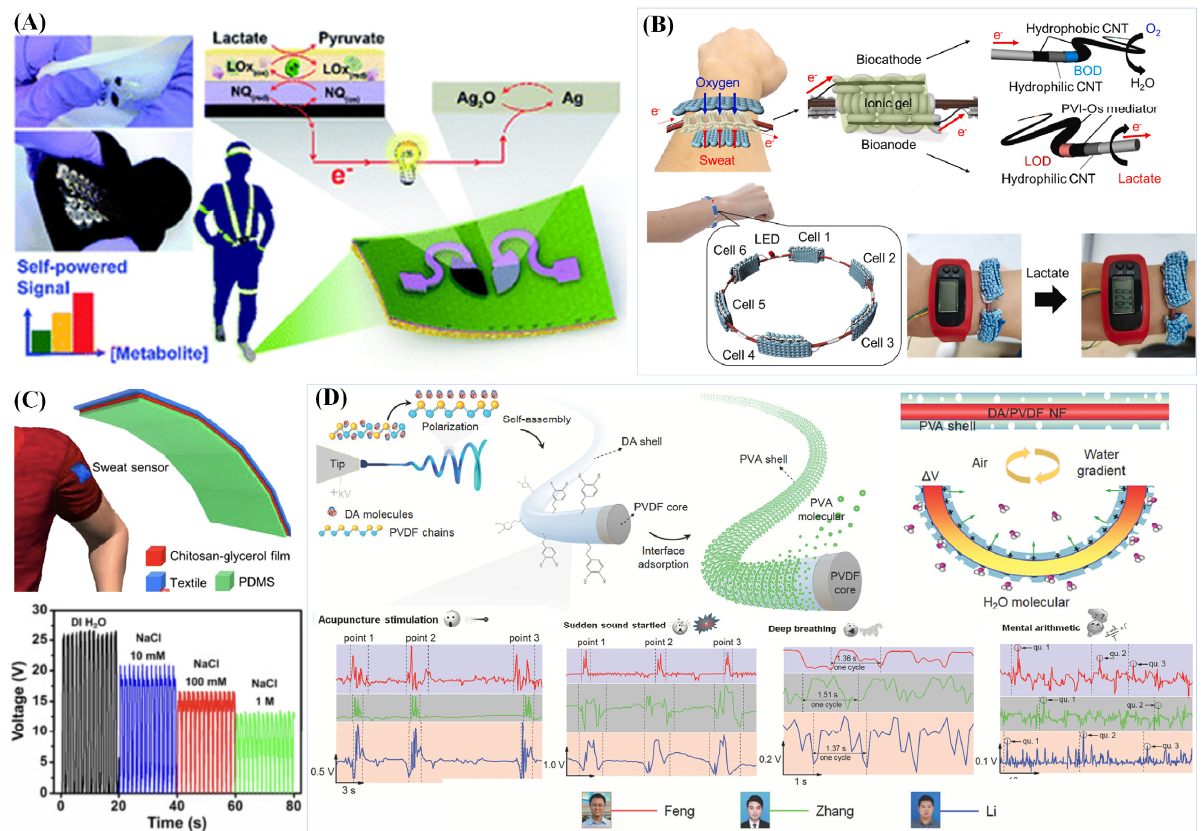
Figure 6. Various self-powered sweat sensors. ( A ) A stretchable BFC based on glucose or lactate with serpentine-patterned electrodes (Reprinted with permission from Ref. [84]. Copyright 2016, copyright Royal Society of Chemistry); ( B ) BFC based on lactate powered a digital wrist watch (Reprinted with permission from Ref. [132]. Copyright 2021, copyright Elsevier); ( C ) The output of liquid–solid contact TENG changed with the concentration of NaCl solution (Adapted with permission from Ref. [82]. Copyright 2018, copyright Elsevier); ( D ) A piezoelectric generator driven by a humidity actuator (Adapted with permission from Ref. [136]. Copyright 2021, copyright Small).